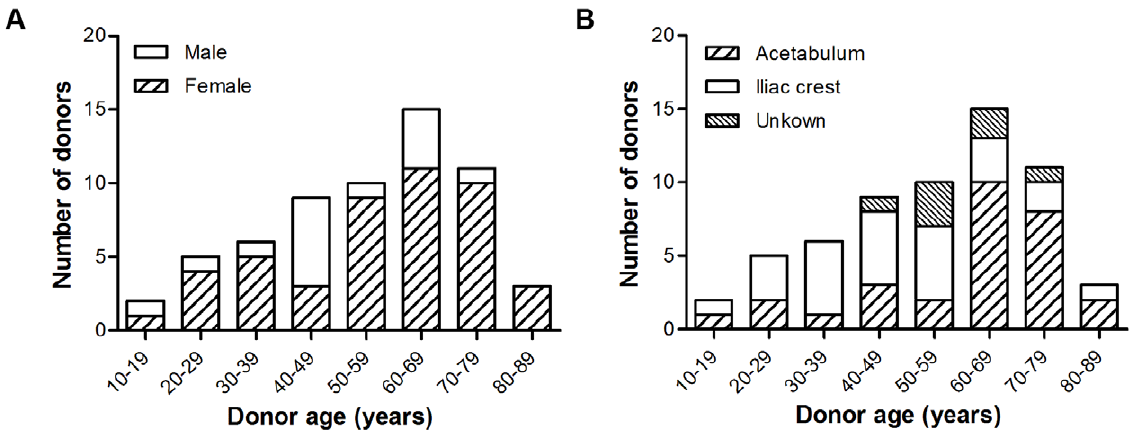
Figure 1. Distribution of the donor population. A) The distribution of sex with age and B) the distribution of site of aspiration with age.